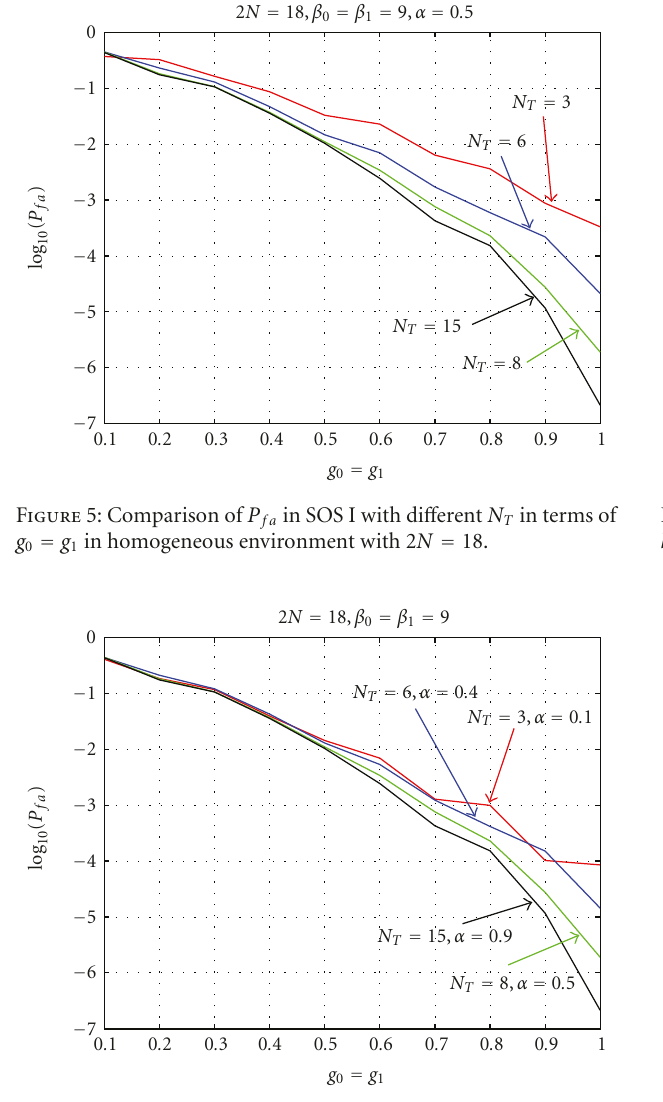
Figure 6: Comparison of P fa for SOS I proce α sor in homogeneous environment in terms of g 0 = g 1 and some di ff erent N T and α with 2 N = 18.